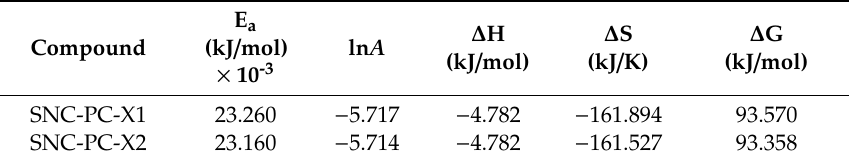
Table 3. Kinetic and thermodynamic parameters of SNC-PC-X1 and SNC-PC-X2 at the decomposition range of 270–340 ◦